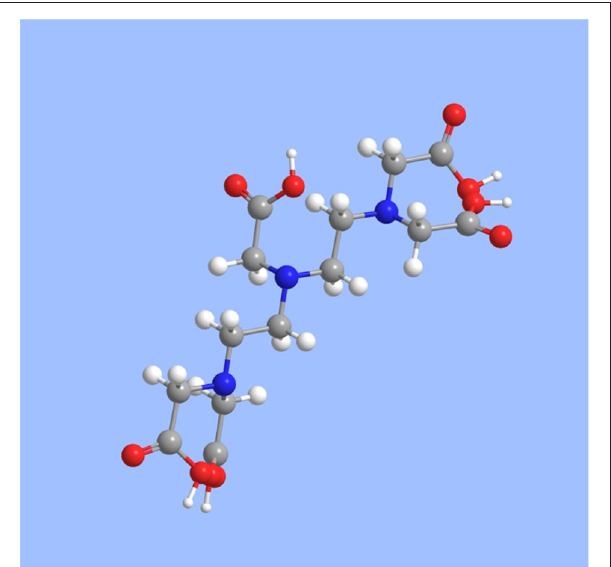
FIGURE 1 | Rendering of the molecular structure of DTPA, produced with ChemDraw v.12.0. Gray = C; white = H; red = O; blue =